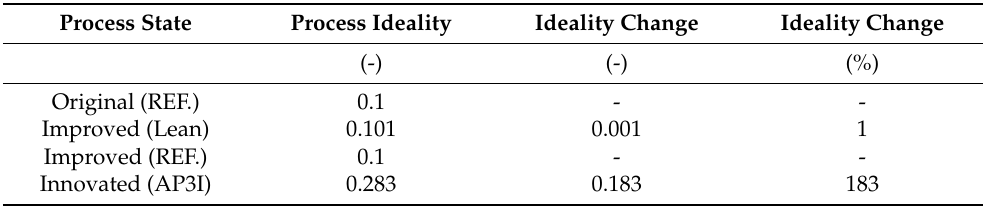
Table 7. Comparison of process ideality—packing process.